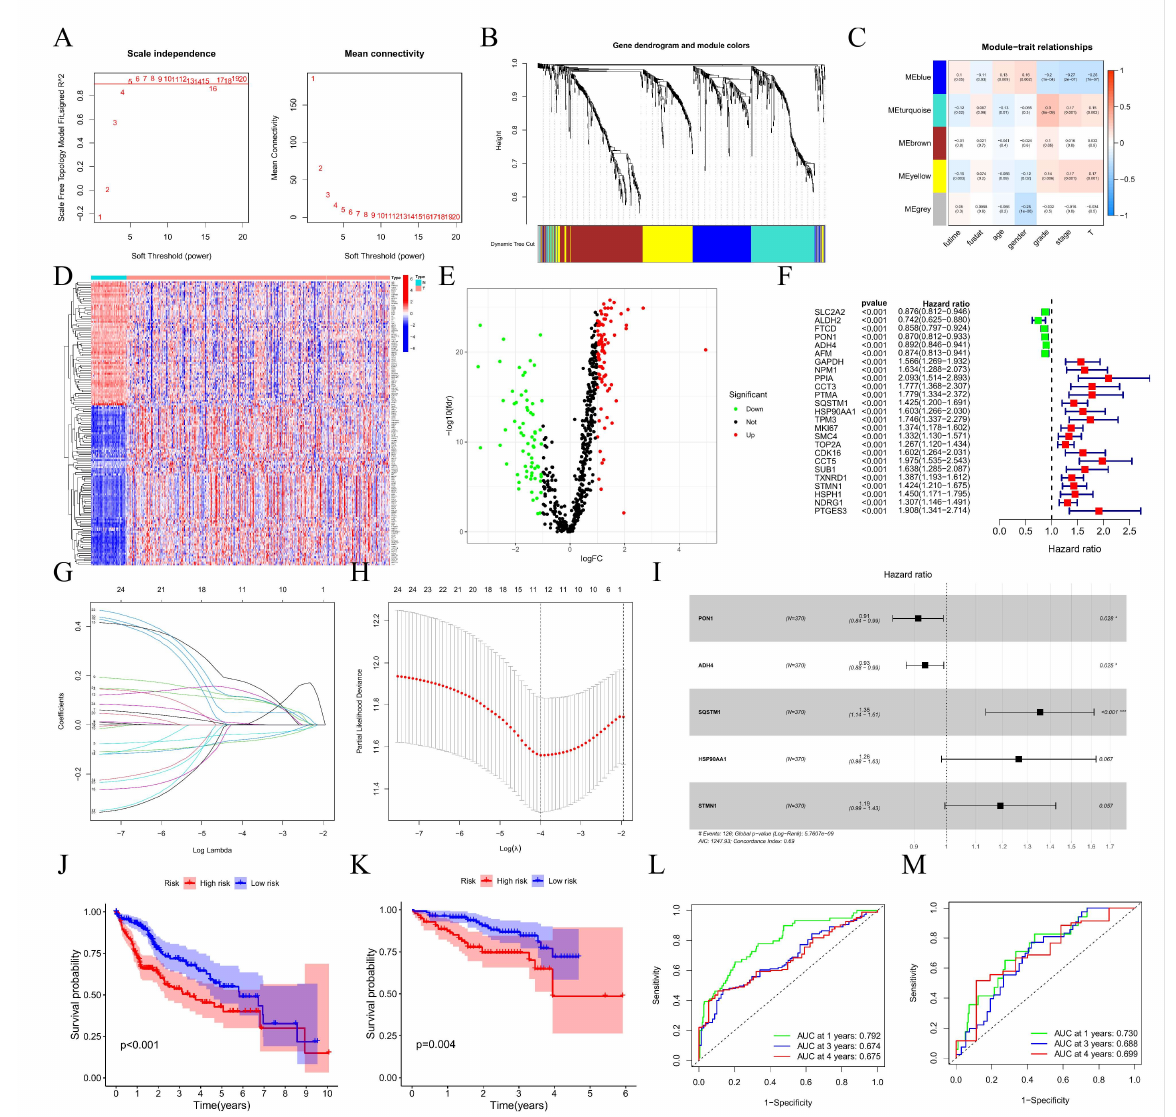
Figure 4. Construction, evaluation, and validation of a DRGPI-based prognostic risk model. ( A , B ) Based on weighted correlation network analysis, 5 modules were accessed with a soft threshold = 9. ( C ) Correlation analysis between modules and clinicopathological data of patients with HCC. ( D ) Heatmap showing the differential expression HDRGs between normal group and tumor group of HCC from TCGA. ( E ) Differential expression analysis identified 158 differentially expressed HDRGs in 3 modules, with |log2(FC)| > 1 and FDR < 0.05. ( F ) Univariate analysis of differentially expressed HDRGs. ( G , H ) Lasso regression analysis. ( I ) Forest plot of the multivariate Cox regression analysis es- tablishing a differentiation-related gene prognostic index (DRGPI) in HCC. ( J ) Kaplan–Meier analysis between the low DRGPI subgroup and high DRGPI subgroup in the TCGA cohort. ( K ) Kaplan–Meier analysis between the low DRGPI subgroup and high DRGPI subgroup in the ICGC cohort. ( L ) In the TCGA cohort, the areas under the ROC curves for predicting 1-year, 3-year, and 4-year OS. ( M ) In the ICGC cohort, the areas under the ROC curves for predicting 1-year, 3-year, and 4-year